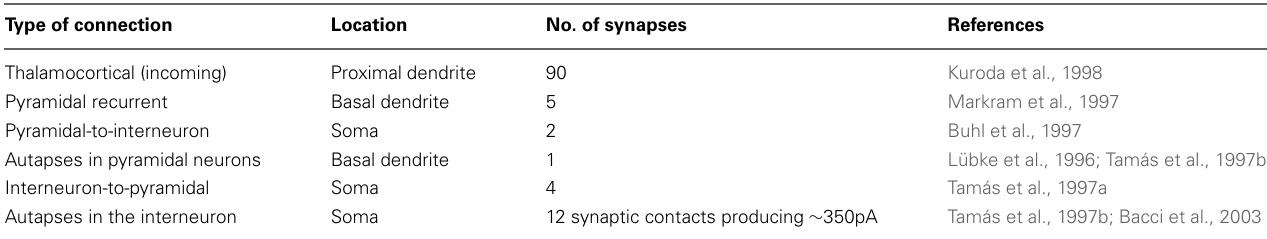
Table 6 | Summary of synaptic connections in the